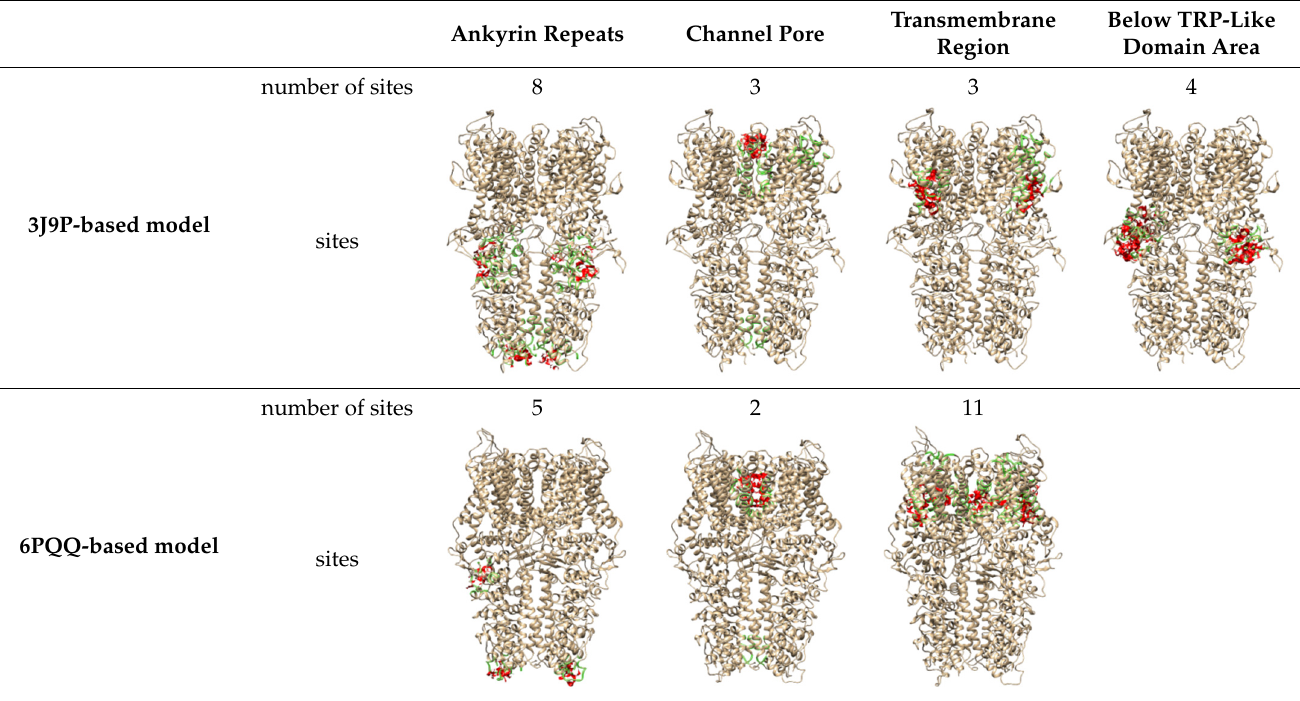
Table 4. Prediction of binding sites from Castp3.0 for models based on 3J9P and 6PQQ: number of sites and graphical illustration (red—the predicted sites).